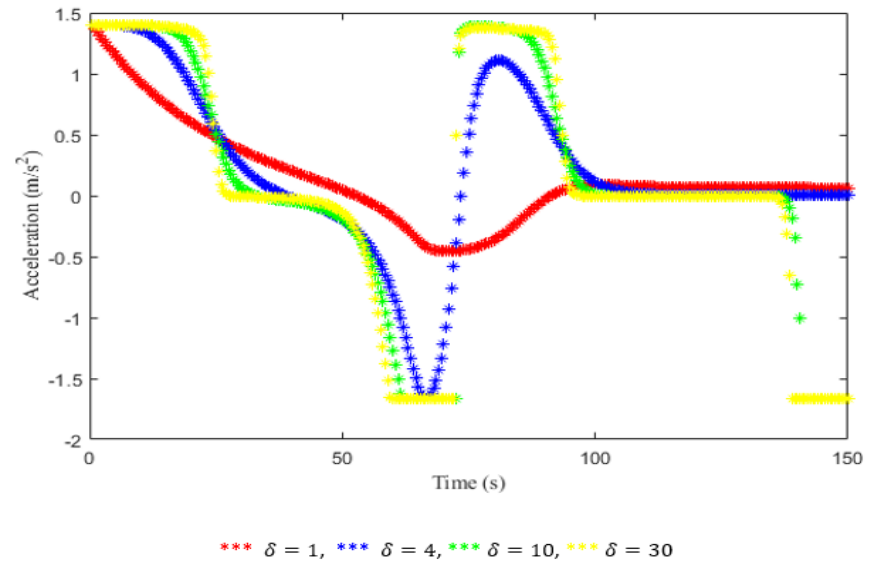
Figure 10. Temporal evolution of acceleration for the ID model.